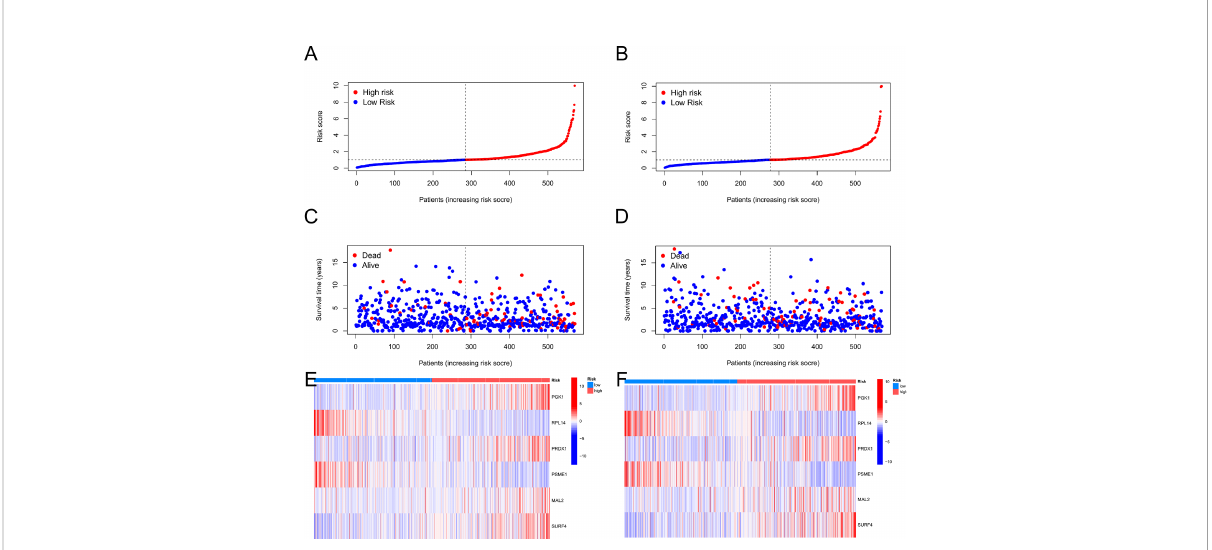
FIGURE 6 The patient survival status and CRG score distribution vary between the train and test sets. (A, C, E) The patient survival status and CRG score distribution in the train set. (B, D, F) The patient survival status and CRG score distribution in the test set.